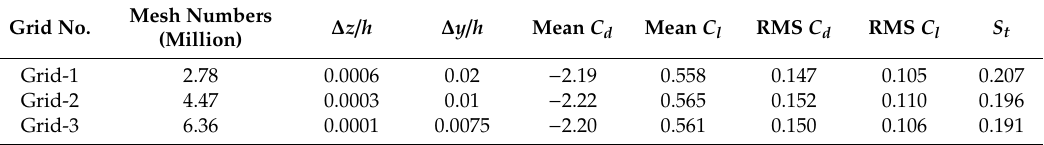
Table 1. Grid independence test of the computational domain with three di ff erent mesh numbers. Grid No.